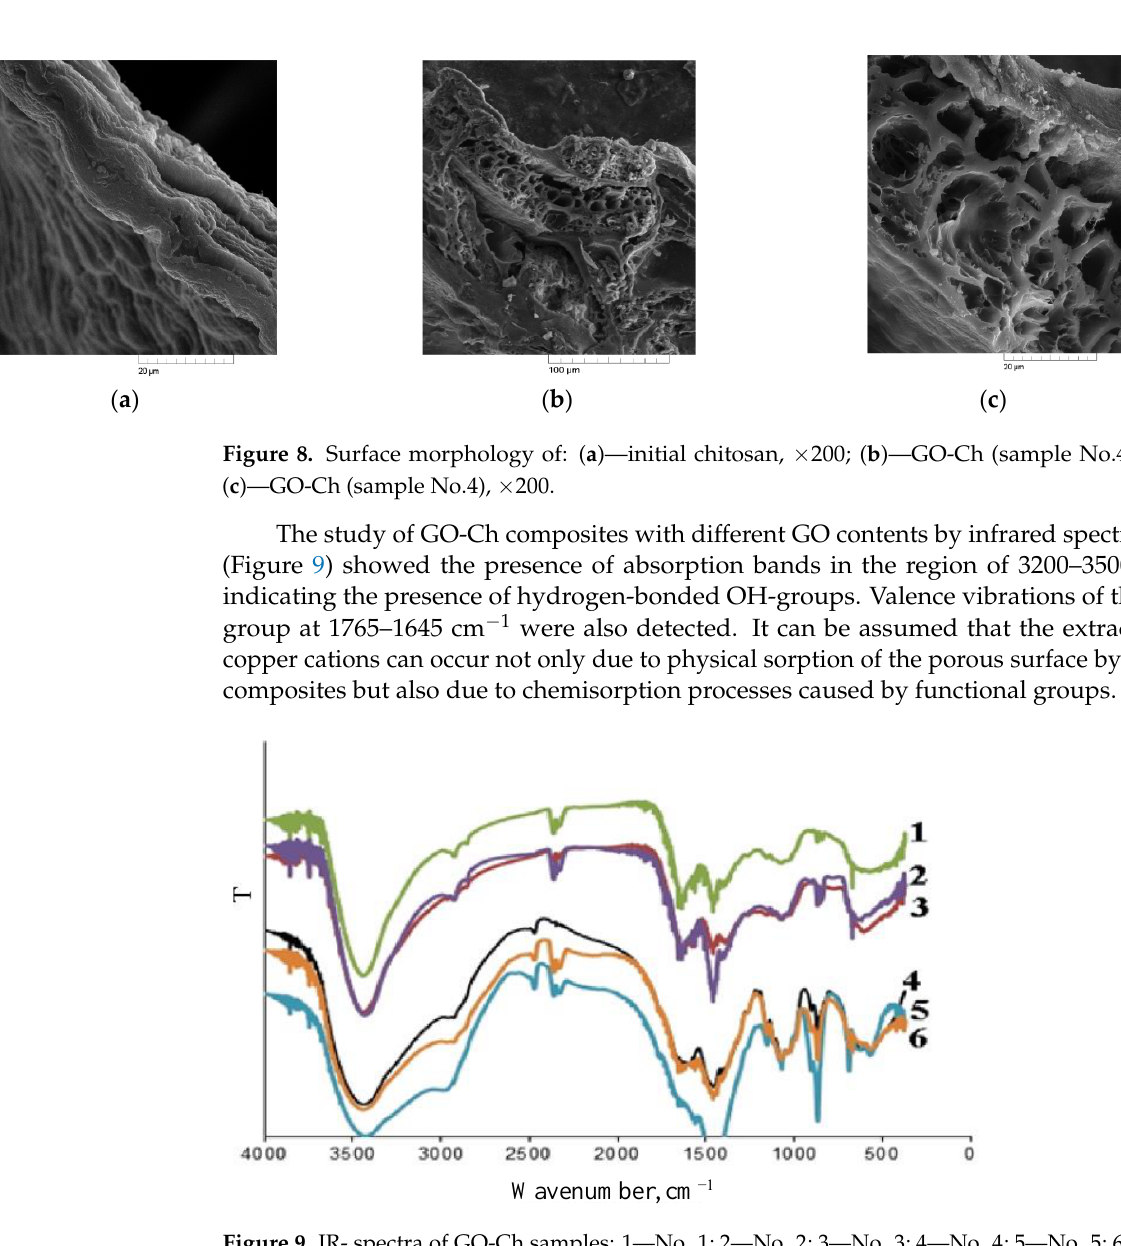
Figure 9. IR- spectra of GO-Ch samples: 1 — No. 1; 2 — No. 2; 3 — No. 3; 4 — No. 4; 5 — No. 5; 6 — No. 6.